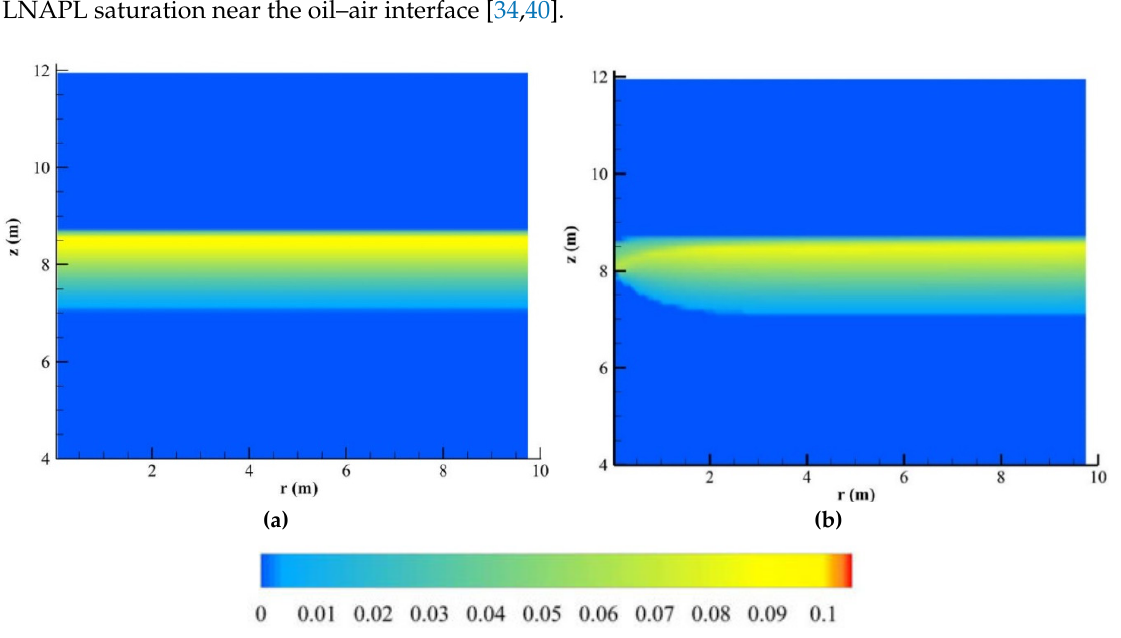
Figure 13. Initial saturation profile ( a ) and after 100 days of diesel extraction ( b ) in silty sand.